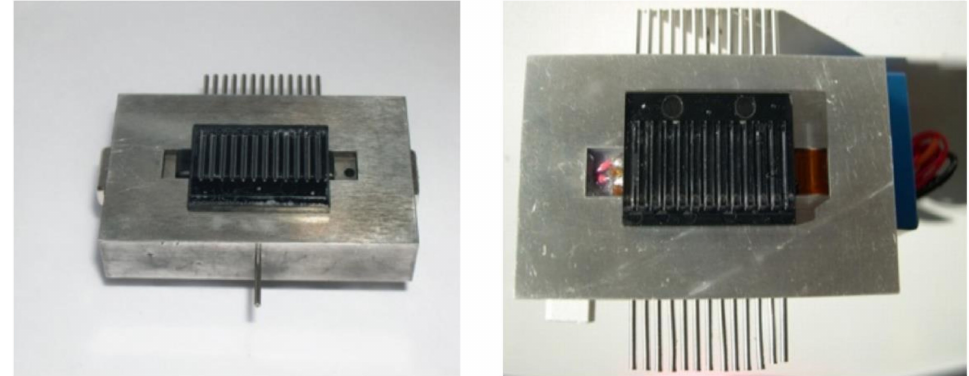
Figure 4. The microfluid chip coupled with the manifold. Left : the manifold used for the sample measurement with one inlet and thirteen outlets; Right : the manifold used for the preparation of the sensing layer with thirteen inlets and thirteen